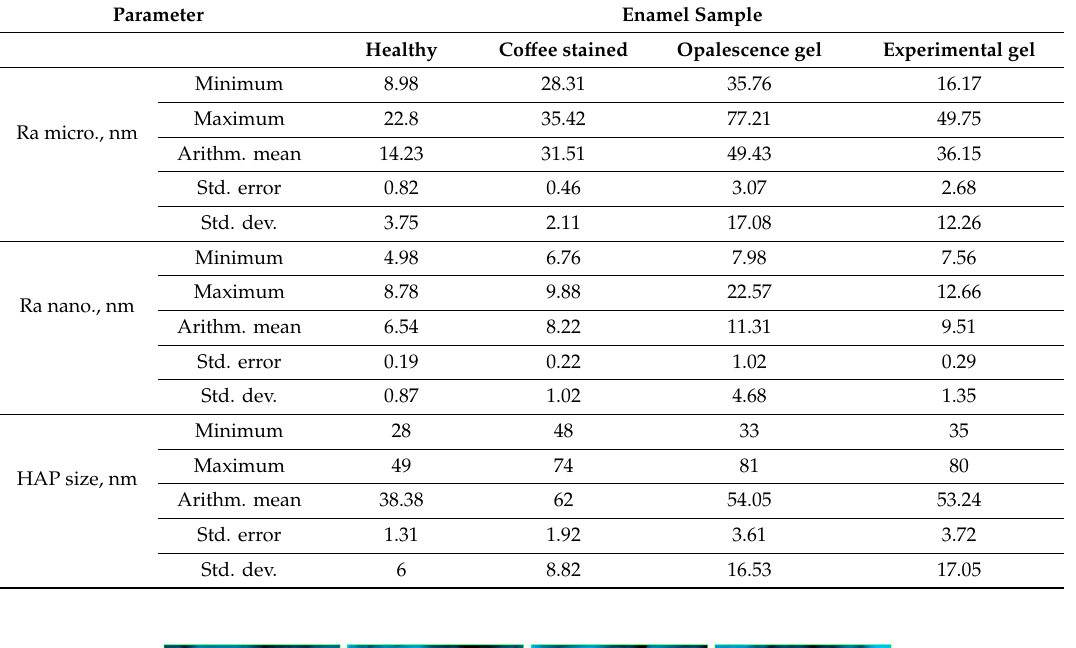
Table 2. Enamel surface parameters measured with AFM.